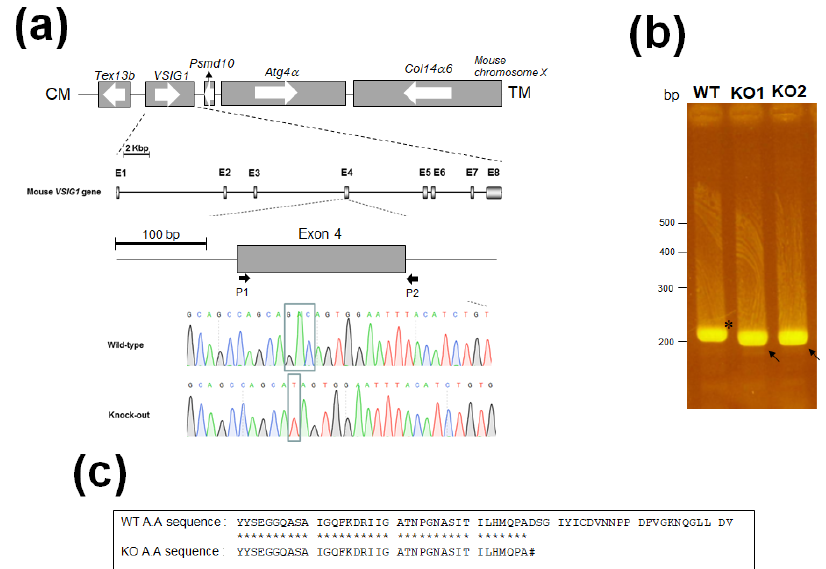
Figure 1. Generation of V-set and immunoglobulin domain-containing 1 (VSIG1) − / − mice using clus- tered regularly interspaced short palindromic repeat/CRISPR-associated protein 9 (CRISPR/Cas9) system. ( a ) Mouse VSIG1 contains eight exons (shaded boxes) interrupted by three introns. The ATG translation initiation codon is located in the second exon. Genomic sequence of the CRISPR target site in VSIG1 +/+ and VSIG1 − / − . Letters in the box indicate the target mutation. ( b ) Genomic DNA PCR from KO mice. Arrowhead means wild-type (WT) band, while arrow means VSIG1 knock out (KO) of male and female. ( c ) Comparison of peptide sequences between wild-type (WT) and knock out (KO) VSIG1 mice. Amino acids identical between two sequences are shown asterisks. # means stop